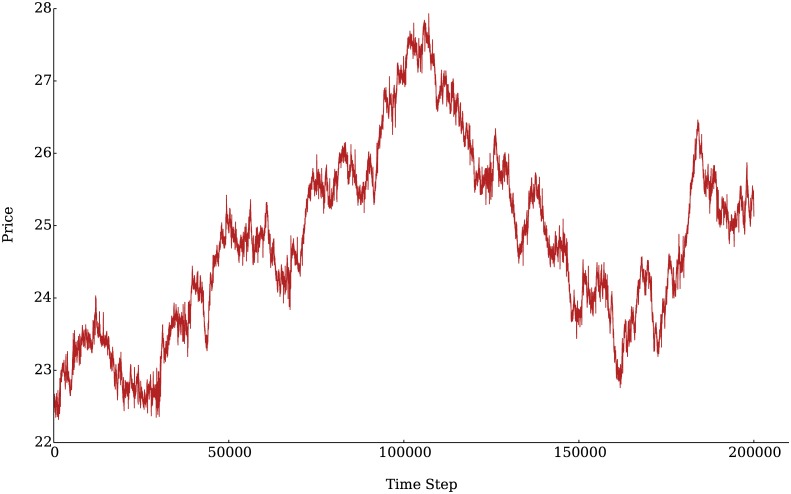
Representative time series of asset prices, determined as the last price the asset was traded at each time step (“closing price”).